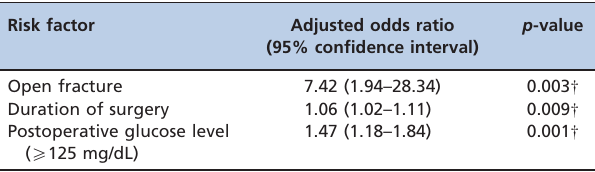
Table 3 - Multivariate Logistic Regression Analysis of Risk Factors for